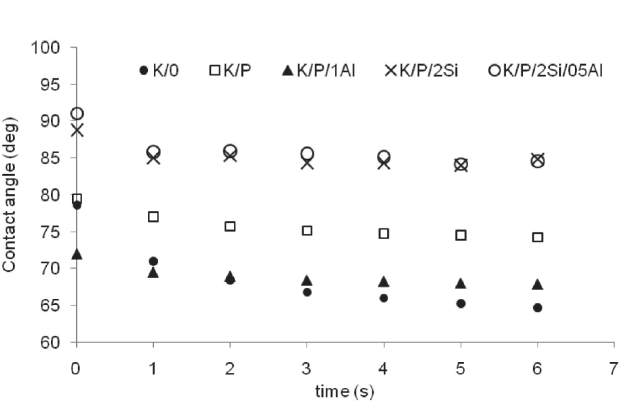
Fig. 3 – SEM micrographs of paperboard samples coated with PCL and modified with SiO